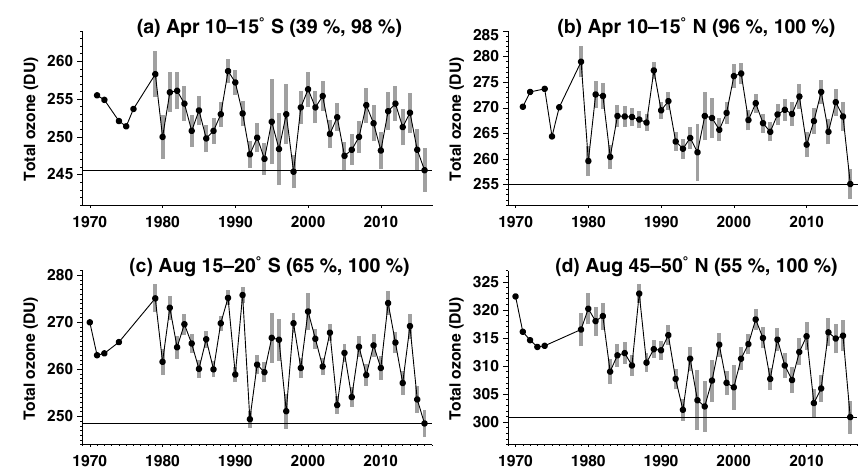
Figure 6. SBUV total ozone (in Dobson units) time series from 1970 to 2016 for April, averaged over (a) 10 ◦ S–15 ◦ S and (b) 10–15 ◦ N, and for August, averaged over (c) 15–20 ◦ S and (d) 45–50 ◦ N . Vertical bars show 1 σ uncertainties in the measurements. The horizontal line shows the total ozone value in April or August 2016 and the panel captions show the percentage estimates of the 2016 value that are the lowest and amongst the lowest 20% of all values. The probability that the 2016 values were record lows was estimated using 10000 Monte Carlo simulations of the monthly means in the time series (Frith et al., 2014).